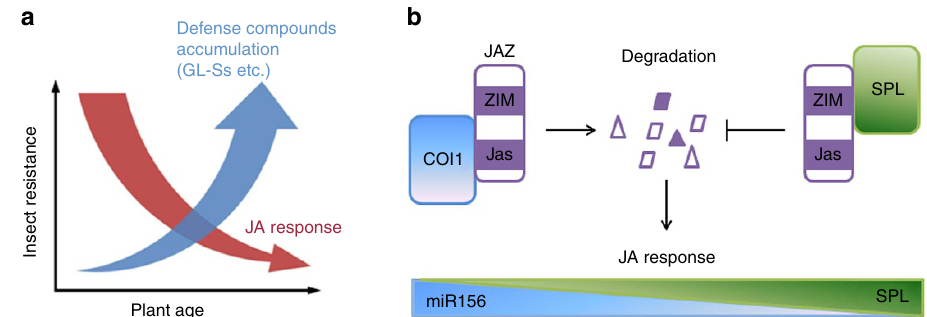
Figure 8 | A model for the age-dependent change of plant resistance to insect herbivores. ( a ) During plant growth, the JA-regulated defense is highly active at juvenile stage but declines with age, while defense compounds accumulate constitutively, which supply the insect resistance continuously during plant growth. ( b ) The miR156-regulated SPL9 group proteins stabilize JAZs though direct binding to its N-terminal. The increased amount of SPL proteins in aged plant promotes JAZ accumulation, which in turn attenuates JA